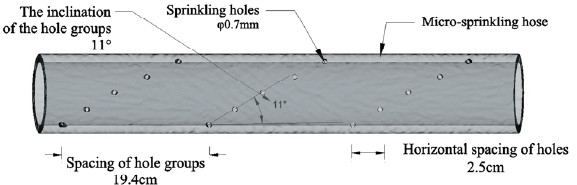
Figure 1. Schematic diagram of the microsprinkler hose. The physical model was established, and the main various parameter indices were obtained according to the microsprinkler hose used in the paper.